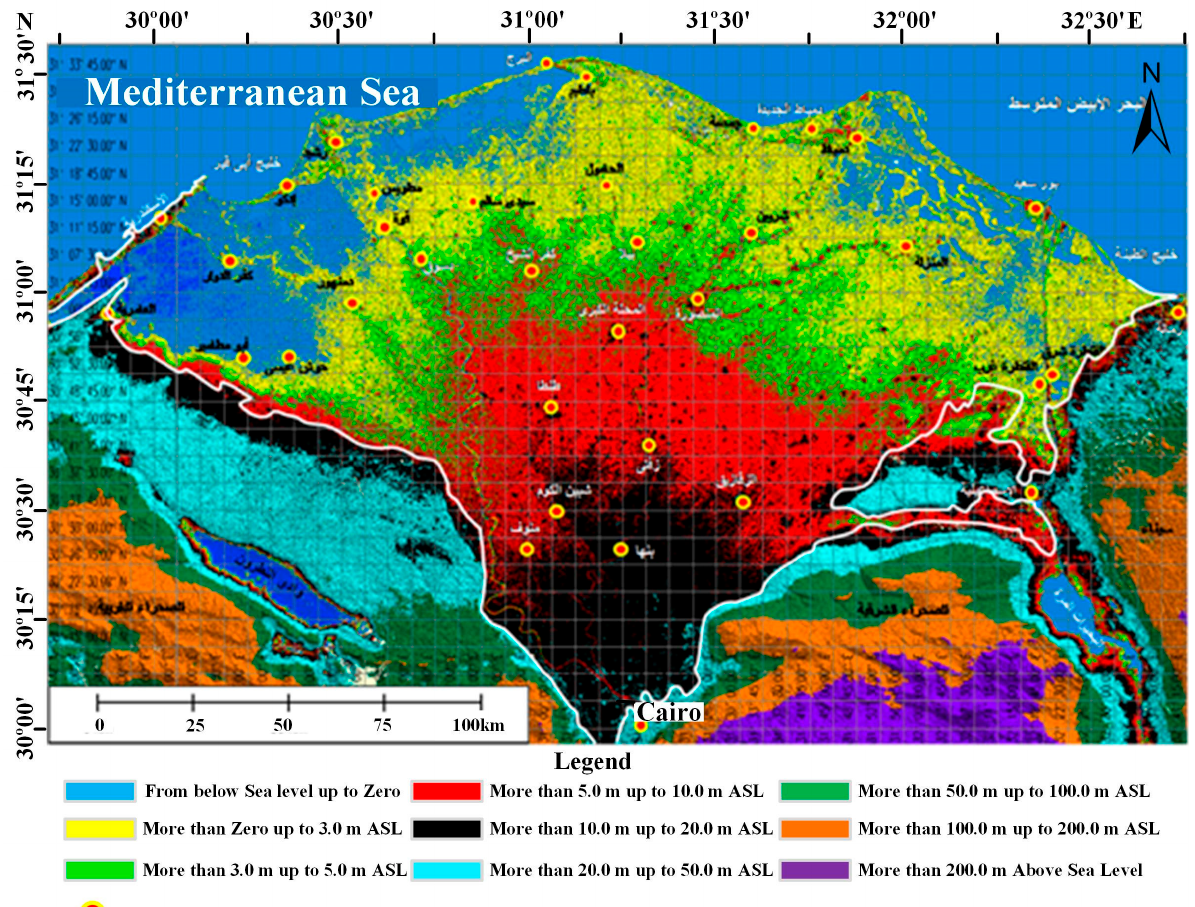
Figure 5. Coastal lowland of the Nile Delta: an extensive area (c. 7000 km 2 ) ranging between 0–3 m above mean sea level is particularly vulnerable to the sea level rise.